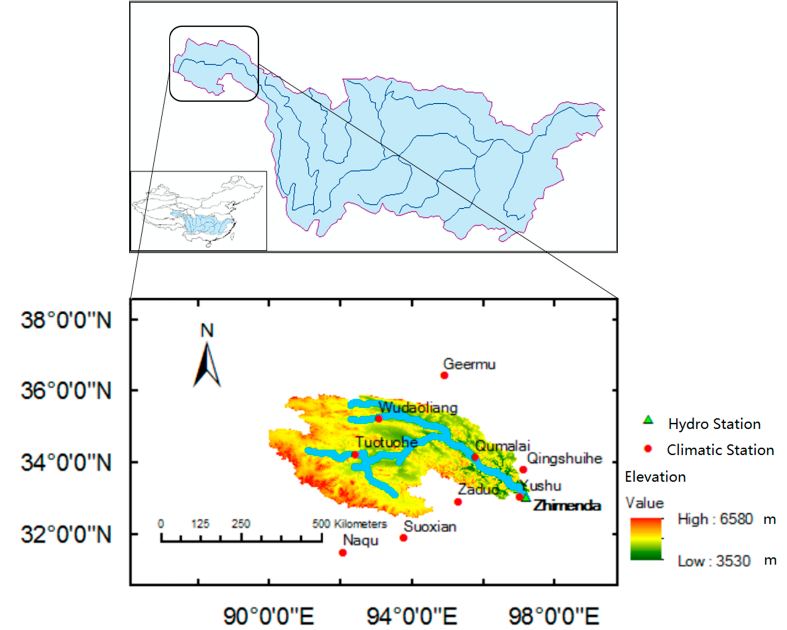
Figure 1. The location of the source region of the Yangtze River with one hydrological and nine climatological observation stations.